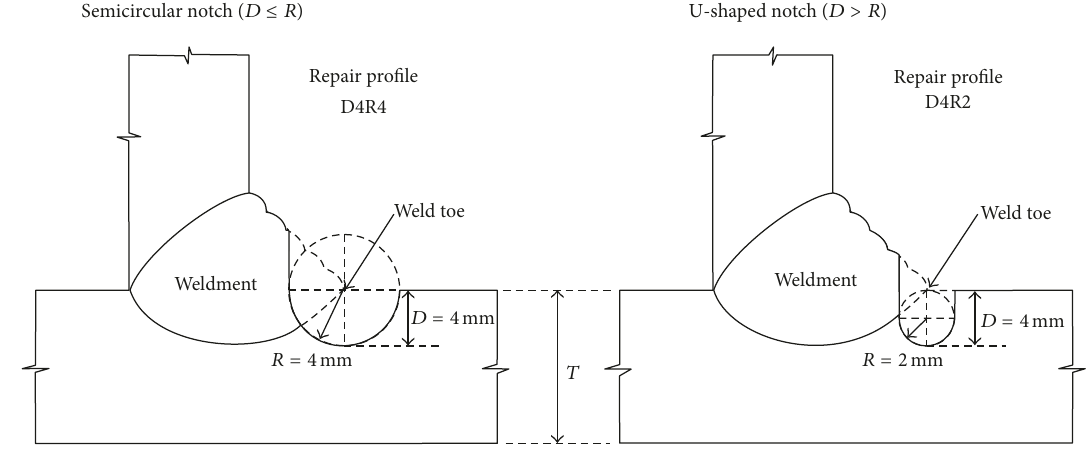
Figure 5: Semicircular and U-shaped repair profiles and dimensions.